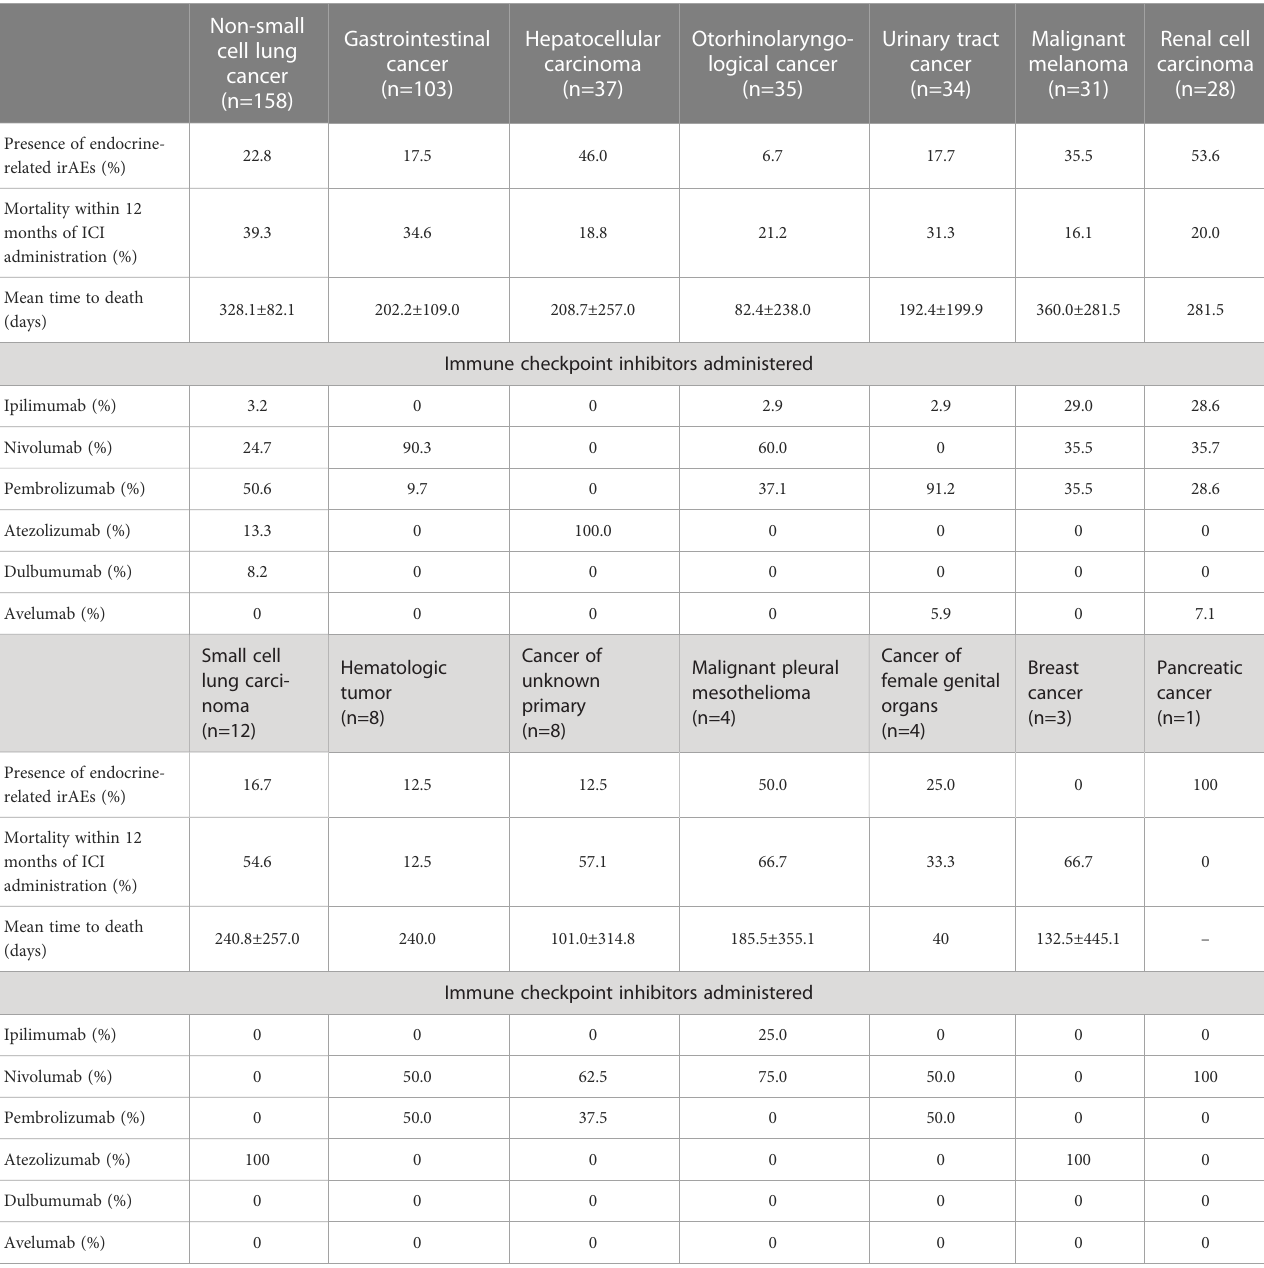
TABLE 1 Prevalence of endocrine-related immune-related adverse events in subjects with various types of cancer. Non-small cell